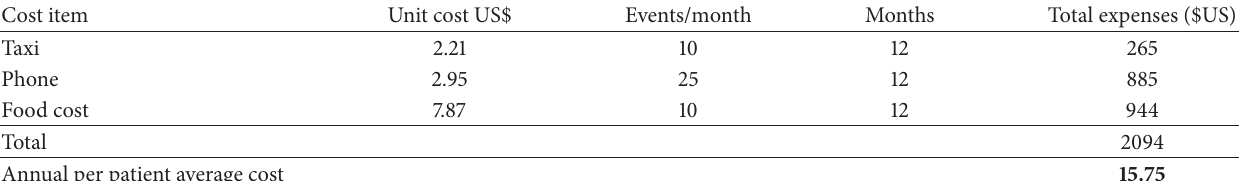
Table 2: Personal expenses of health workers in all hospitals.